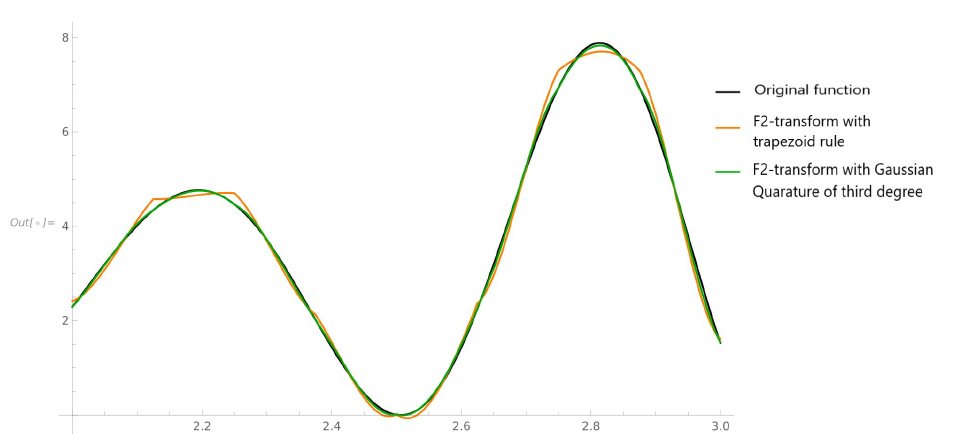
Figure 3. Original function f ( x ) = x 2 ( sin x 2 ) 2 and its two inverse F 2 -transforms whose components were calculated using the trapezoid rule and the here proposed 3-point Gaussian quadrature rule.